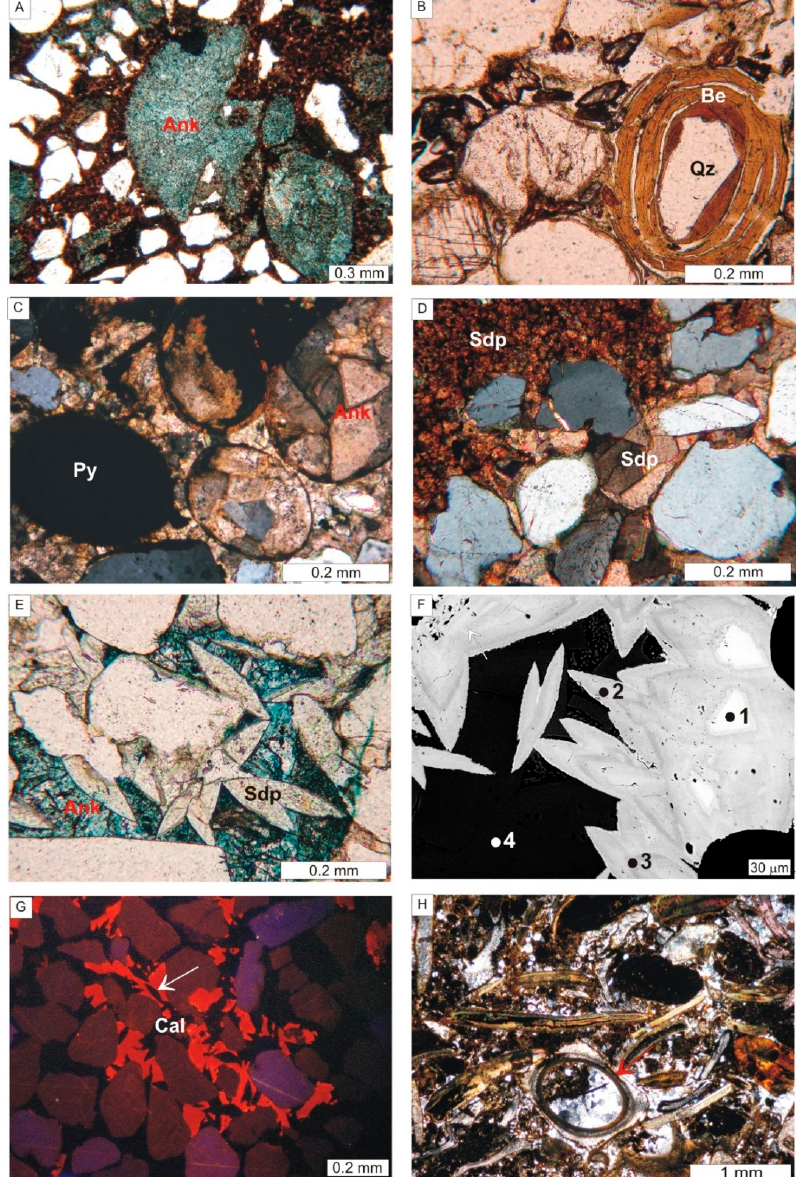
Figure 5. Photomicrographs of siderite rocks in polarizing microscope (PL), cathodoluminescence (CL), and scanning electron microscope (BSE). ( A ) Sideritic sandstone with micrite sideroplesite cement (Sdp). Note ankeritic bioclasts (Ank—blue color); Mniszków IG 1borehole, depth 916.9 m, PL—one nicol. ( B ) Berthierine ooid (Be) with concentric lamellae and quartz (Qz) nucleus in sideritic sandstone; Gutwin borehole, depth 124.2 m, PL—one nicol. ( C ) Ankerite (Ank) and pyrite (Py) ooids in sideritic sandstone; W ˛aglany k/Opoczna borehole, depth 482.7 m, PL—crossed nicols. ( D ) Microsparite and sparite sideroplesite (Sdp) in sideritic sandstone; Gutwin borehole, depth 207.95 m, PL—crossed nicols. ( E ) Rhomboedrons of sideroplesite (Sdp) and ankerite (Ank) cement in sideritic sandstone; Mołdawa borehole, depth 243.5 m, PL—one nicol. ( F ) Rhomboedrons of sideroplesite– pistomesite with a zonal structure in sideritic sandstone; points of chemical analyses (EDS) in siderite (Table S2); Mołdawa borehole, depth 243.5 m, BSE image. ( G ) Fragment of sideritic sandstone, CL image. Nonluminescent rhomboedrons of sideroplesite (arrow) and red luminescence of calcite (Cal) cement; Gutwin borehole, depth 201.6 m. ( H ) Fragments of serpulid tube (arrow) and bivalve shells in sideritic conquina; Wyszmont ó w 1 borehole, depth 99.3 m, PL—crossed